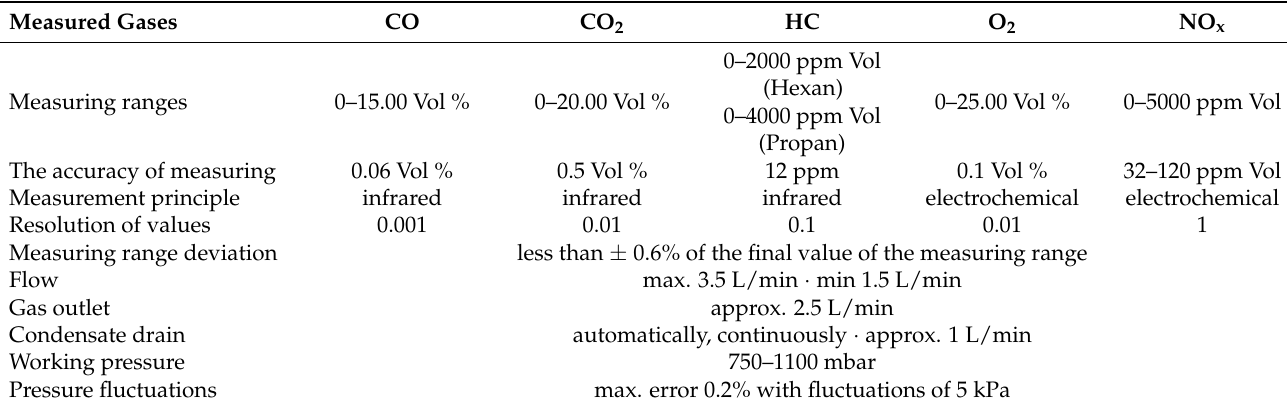
Table 2. Technical data of MAHA MGT 5. Source: